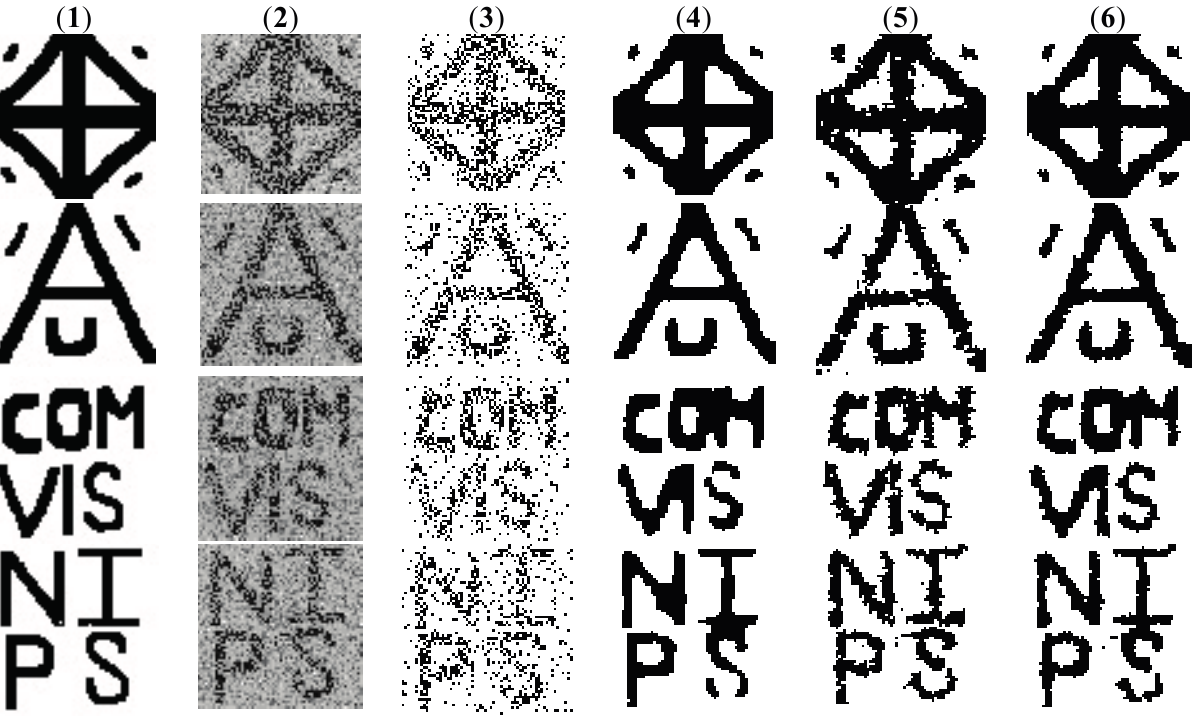
Figure 5. Results of binary denoising task. Column ( 1 ) reference images; ( 2 ) images corrupted with bimodal noise; ( 3 ) logistic classifier results; ( 4 ) results of the grid structured CRF model with loopy belief propagation inference; ( 5 ) result using one spanning tree; ( 6 ) CRF spanning trees cascade